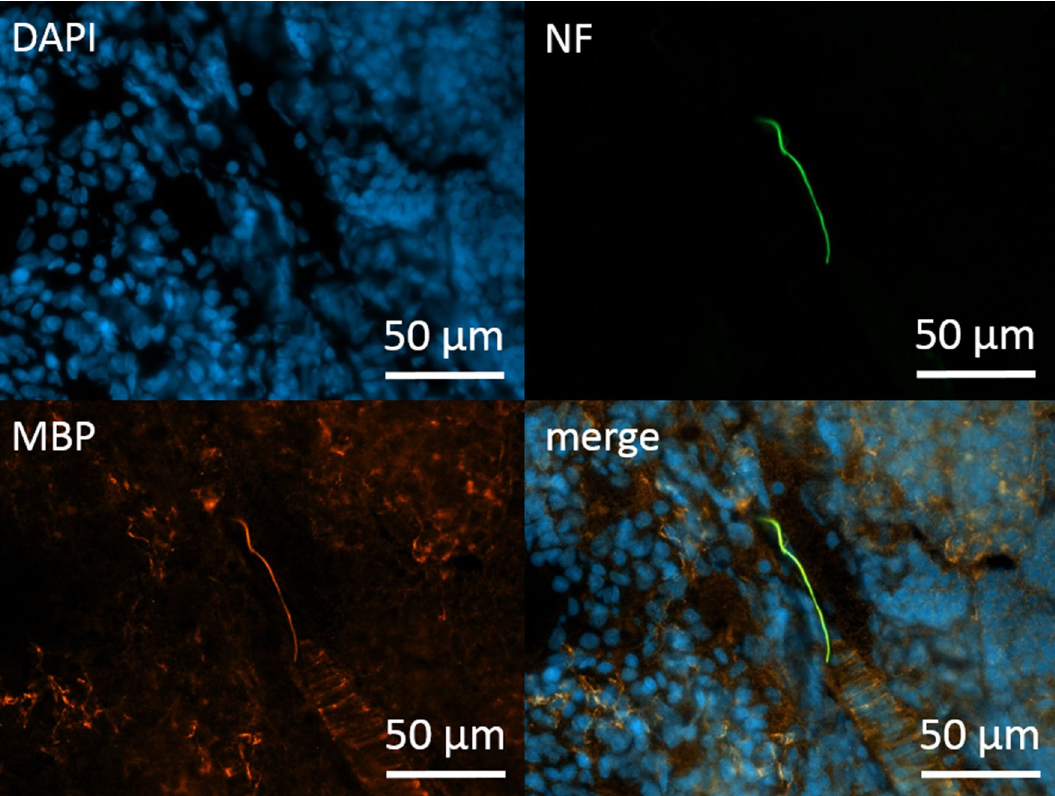
Figure 1. Immunhistochemical staining for Schwann cells in the medulla of a cervical lymph node. Co-staining of neurofilament SMI 312 (directly conjugated, green) and myelin basic protein (MBP) (orange). DAPI for nuclear staining in